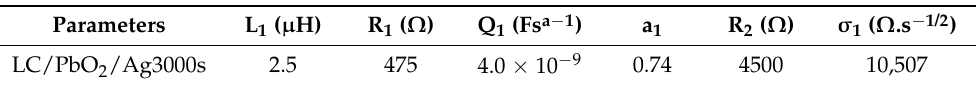
Table 2. Best-fitting parameters for sample LC/PbO 2 /Ag3000s according to the circuit shown in Figure